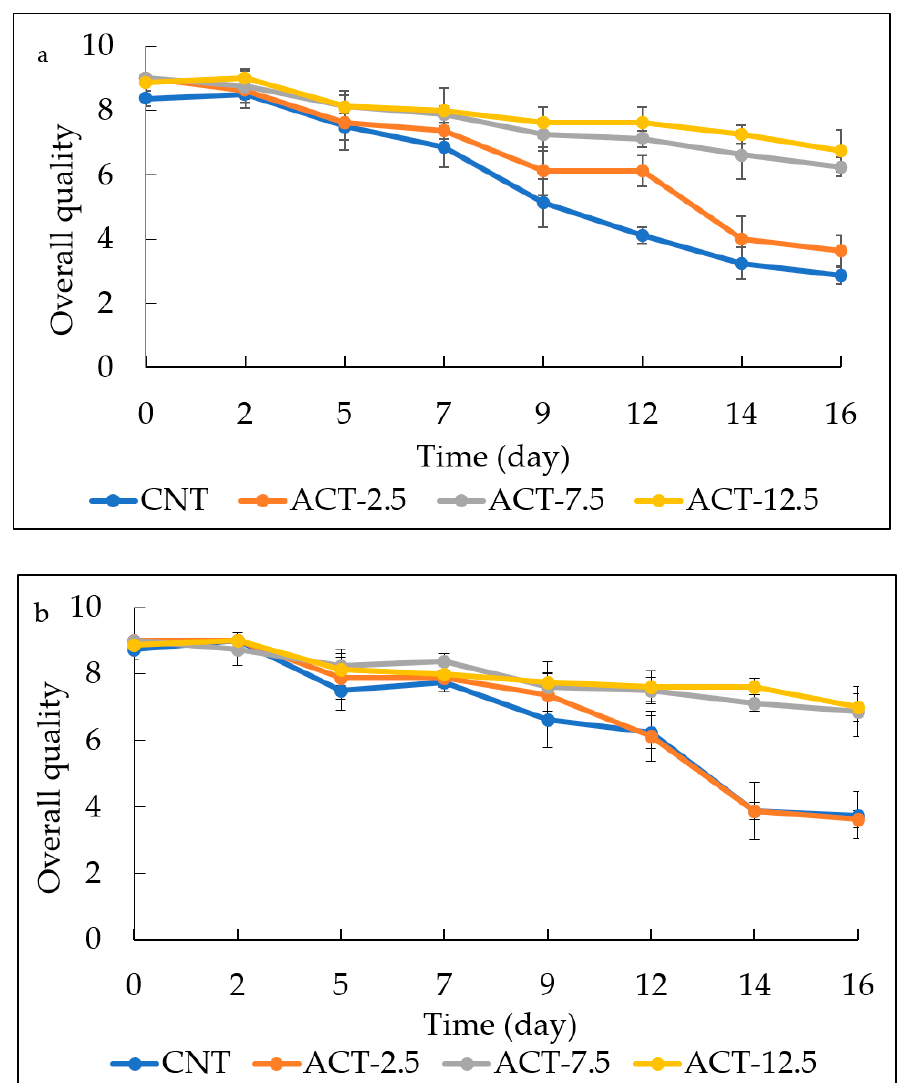
Figure 6. Evolution of Overall quality of both raw ( a ) and cooked ( b ) fish burgers during 16 days of storage. Data indicate means ± SD. CNT: fish burger without prickly pear powder; ACT-2.5: fish burger enriched with 2.5 g of prickly pear powder; ACT-7.5: fish burger enriched with 7.5 g of prickly pear powder; ACT-12.5: fish burgers enriched with 12.5 g of prickly pear powder.